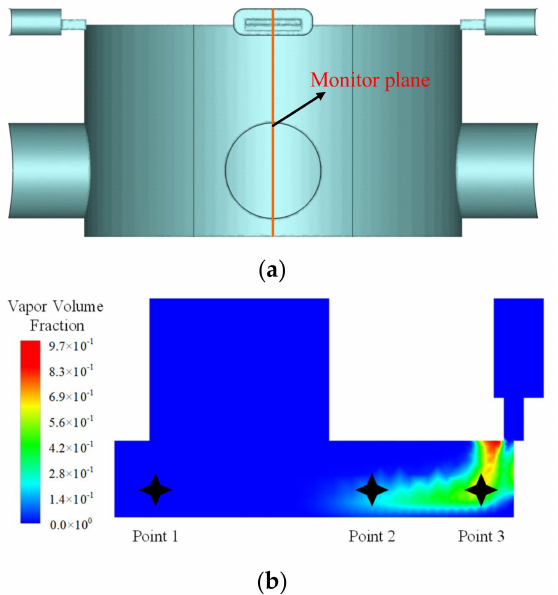
Figure 6. Location of the monitoring surface and points: ( a ) Monitoring surface; ( b ) Monitoring point.